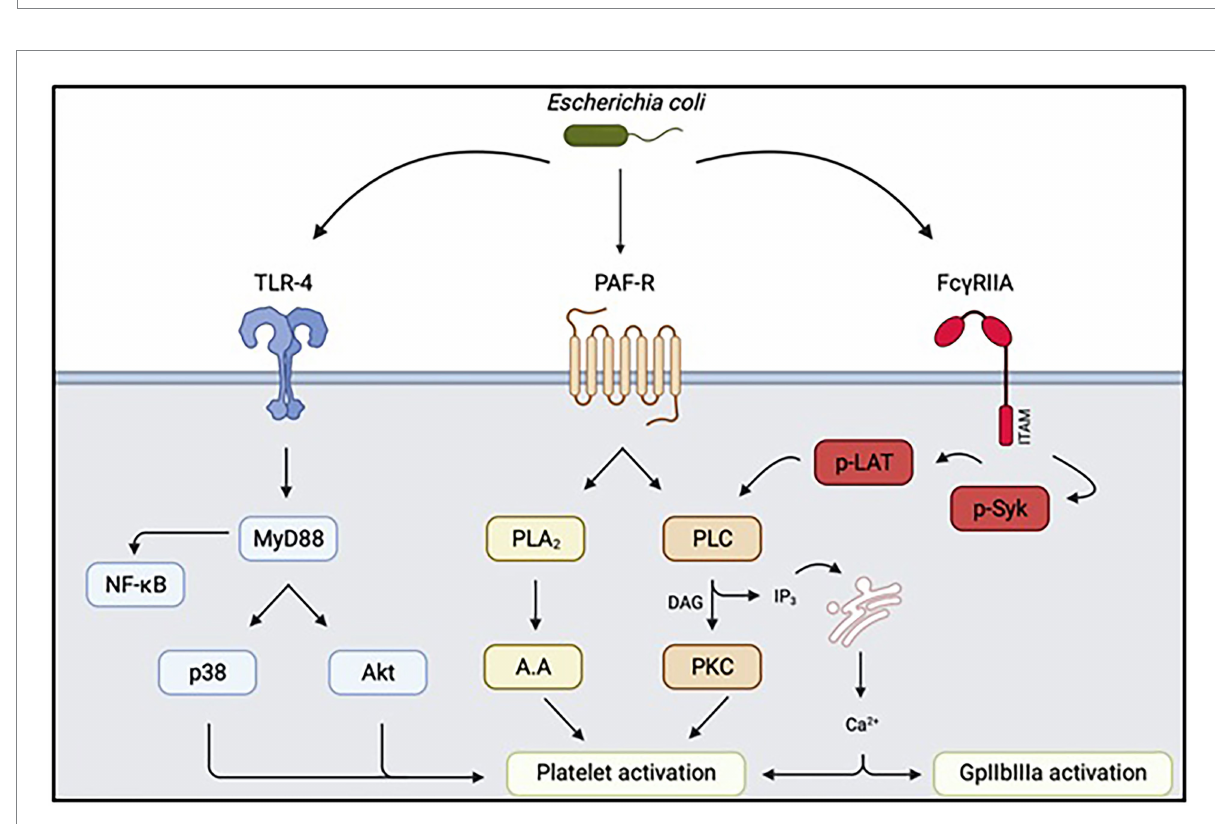
FIGURE 3 Summary of intra-platelet signaling pathways secondary to interaction with Escherichia coli. Depending on the strain involved, the signaling pathways involved in triggering platelet activation and aggregation may be different. TLR4: Toll-like Receptor 4, PAF-R: Receptor of Platelet Activating Factor, Fc γ RIIA: Platelet Fc γ receptor, Akt: protein kinase B, PLA2: phospholipase A2, PLC: phospholipase C, p-LAT: phospho-LAT, PKC protein kinase C. Diagram created on